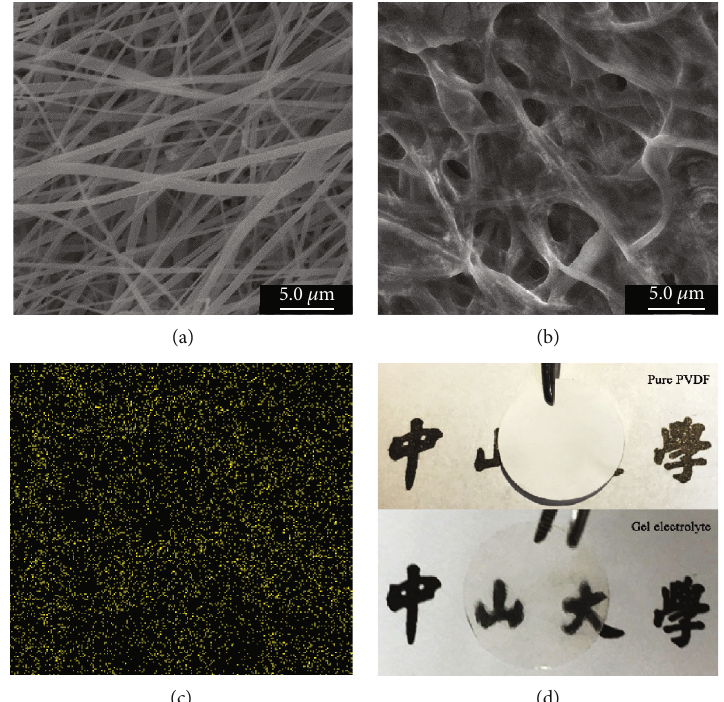
Figure 5: (a) SEM image of original PVDF separator, (b) SEM image of GPE@PVDF membrane, (c) Sulphur distribution in GPE@PVDF membrane, and (d) Photos of PVDF separator and GPE @ PVDF membrane.